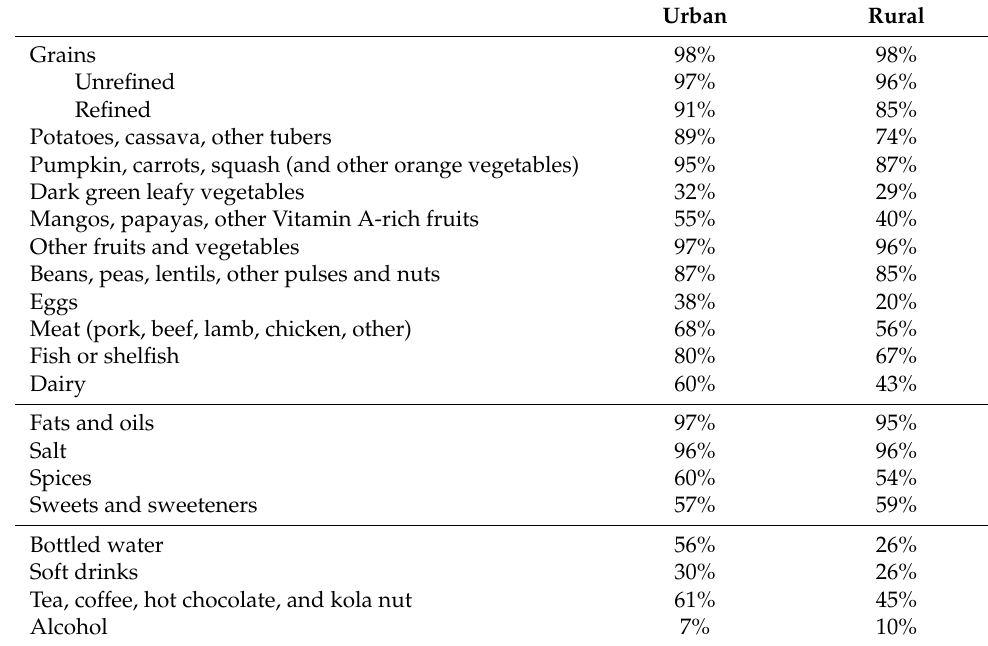
Table 3. Food groups eaten by urban and rural Nigerian households in the 7 days prior to the survey